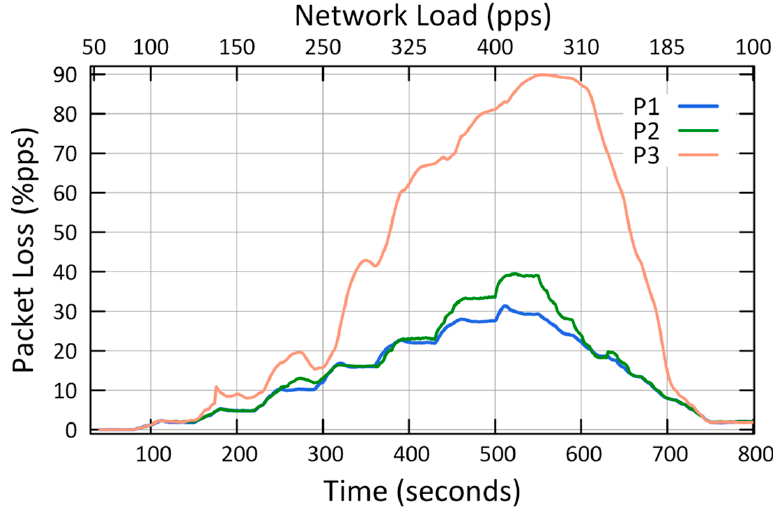
Figure 7. Transmission latency (L) of node 1.